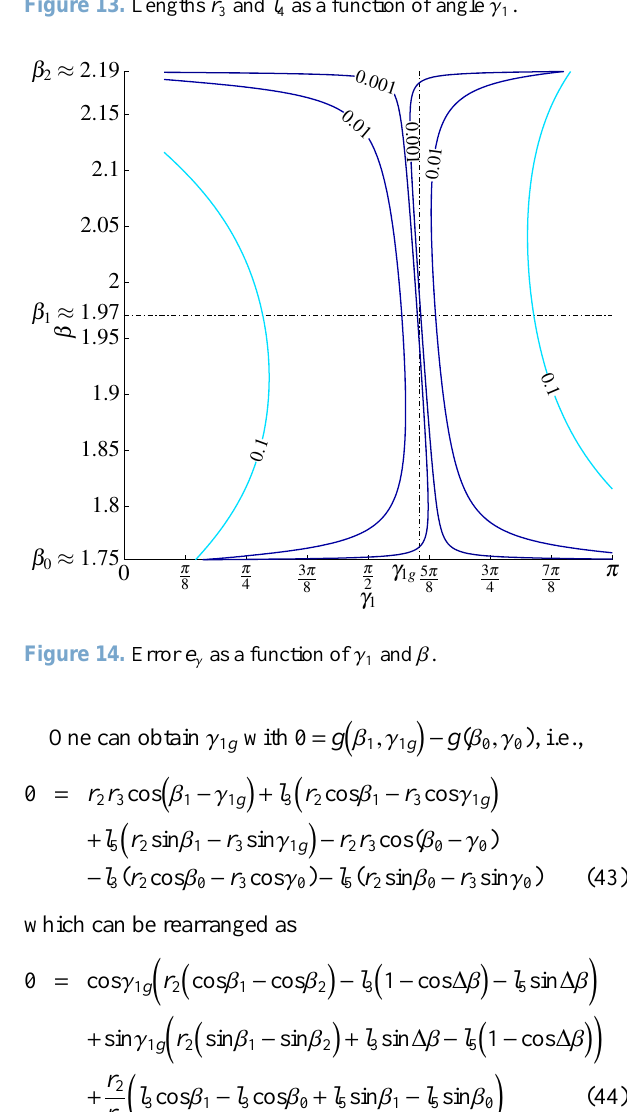
Figure 13. Lengths r 3 and l 4 as a function of angle γ 1 .